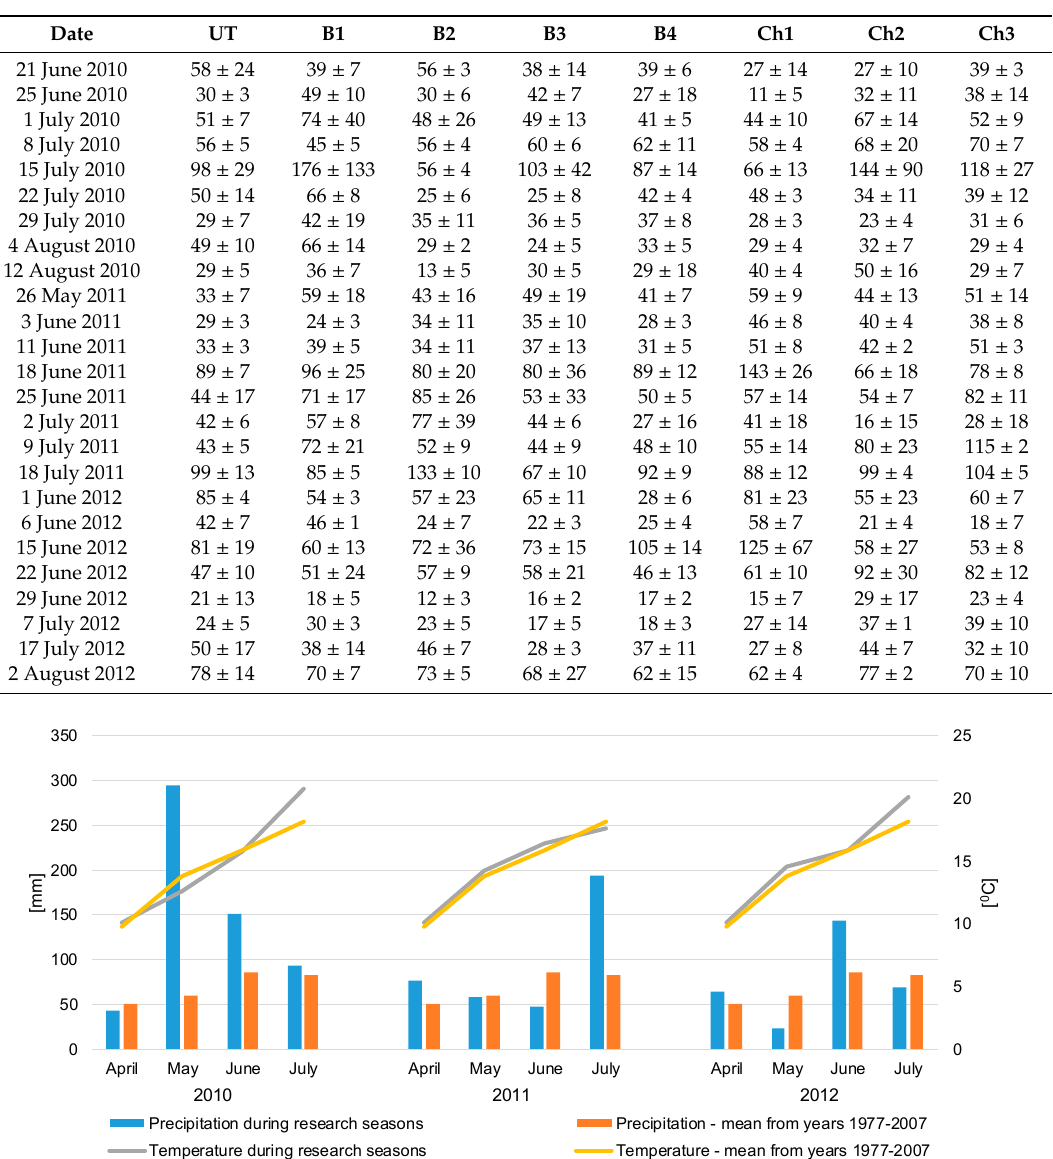
Table 2. Trapping dynamics of investigated arthropodofauna (means of individuals / trap) in broad bean crop: Treatments are the same as in Table 1. Values after ± symbol denote standard errors.